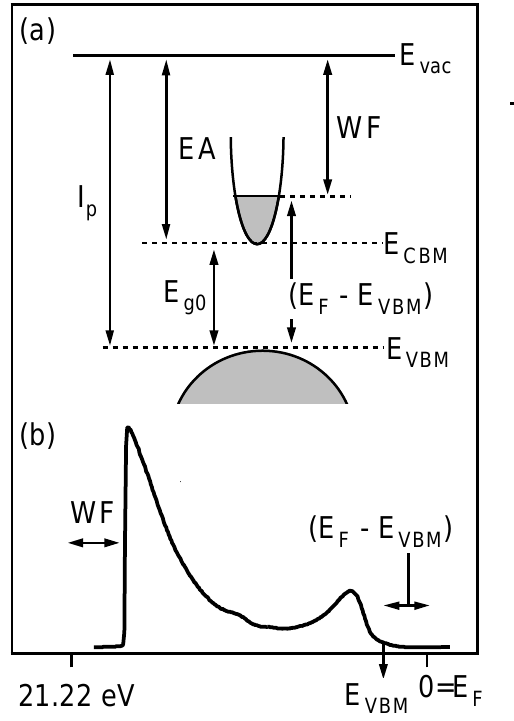
Figure 1. Schematics of typical TCO band structure (a) and UPS spectrum (b); I E , E , E , E , and E denote ionization potential, work function ( ϕ ), electron g0 vac CBM VBM F affinity ( χ ), intrinsic band gap, vacuum level, conduction band minimum, valence band maximum, and Fermi level,